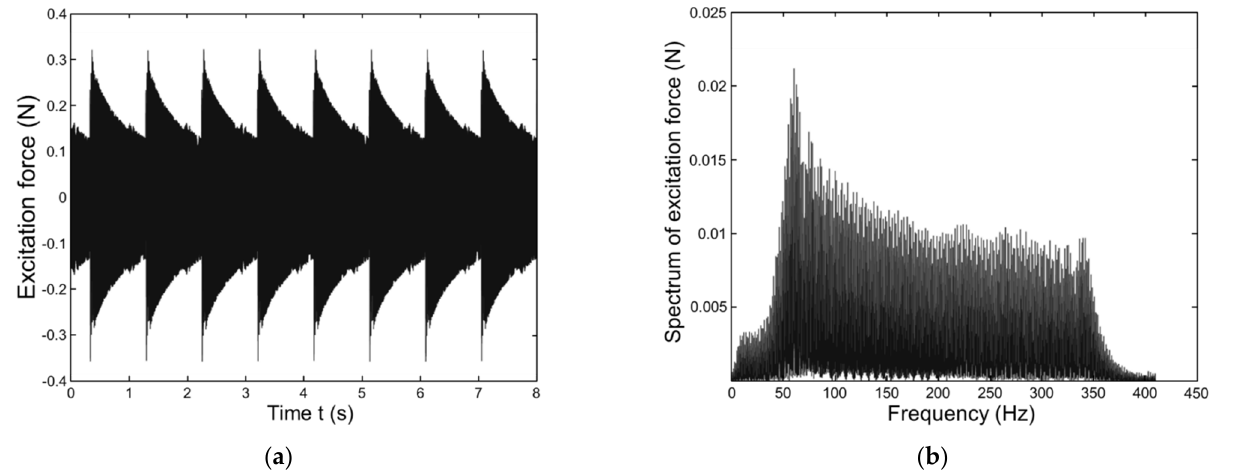
Figure 4. Ambient excitation force. ( a ) Time domain. ( b ) Spectrum.